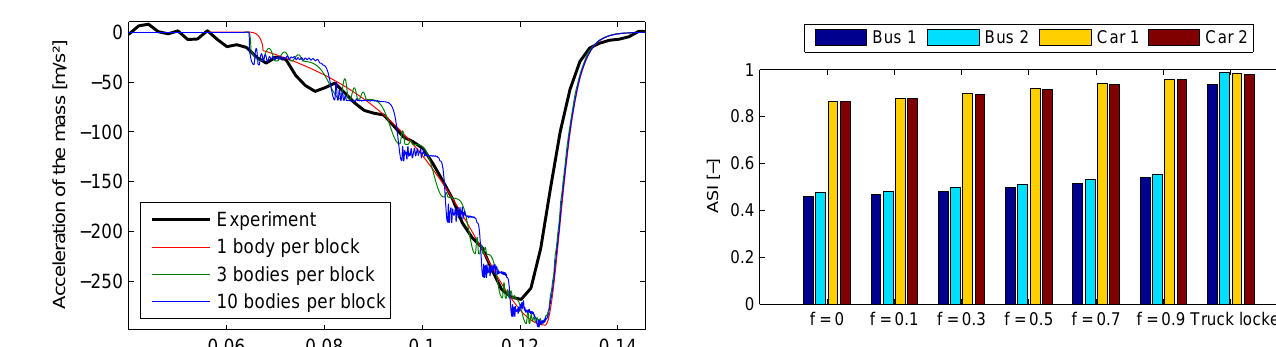
Figure 21. Impact of the friction coe ffi cient f between the ground and the wheels of the truck. The Bus 2 and Car 2 cases correspond to the simulation of a vehicle with a front deformation law sti ff er than the Bus 1 and Car 1 cases.